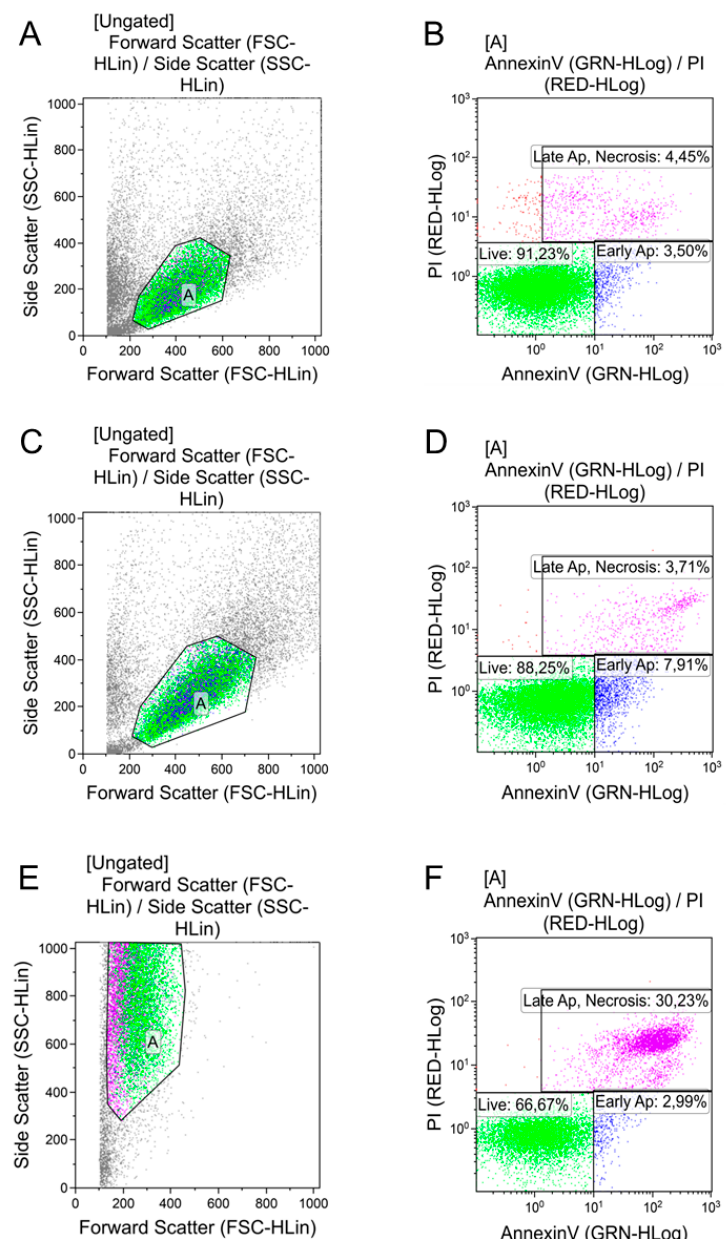
Figure 6. Morphology and apoptosis rates of human adipose-tissue-derived mesenchymal stem cells after incubation with PBS, albumin-, and Tween-80-coated AgNPs. Cell morphology according to forward and side scattering profiles obtained with flow cytometry analysis in ( A ) PBS-treated cells, ( C ) AgNPs–Alb 100 μ L, and ( E ) AgNPs–Tween 100 μ L groups. Representative scatter plots of propidium iodide ( y ‐ axis) versus annexin V ( x ‐ axis) in ( B ) PBS ‐ treated cells, ( D ) AgNPs–Alb 100 μ L, and ( F ) AgNPs–Tween 100 μ L groups.